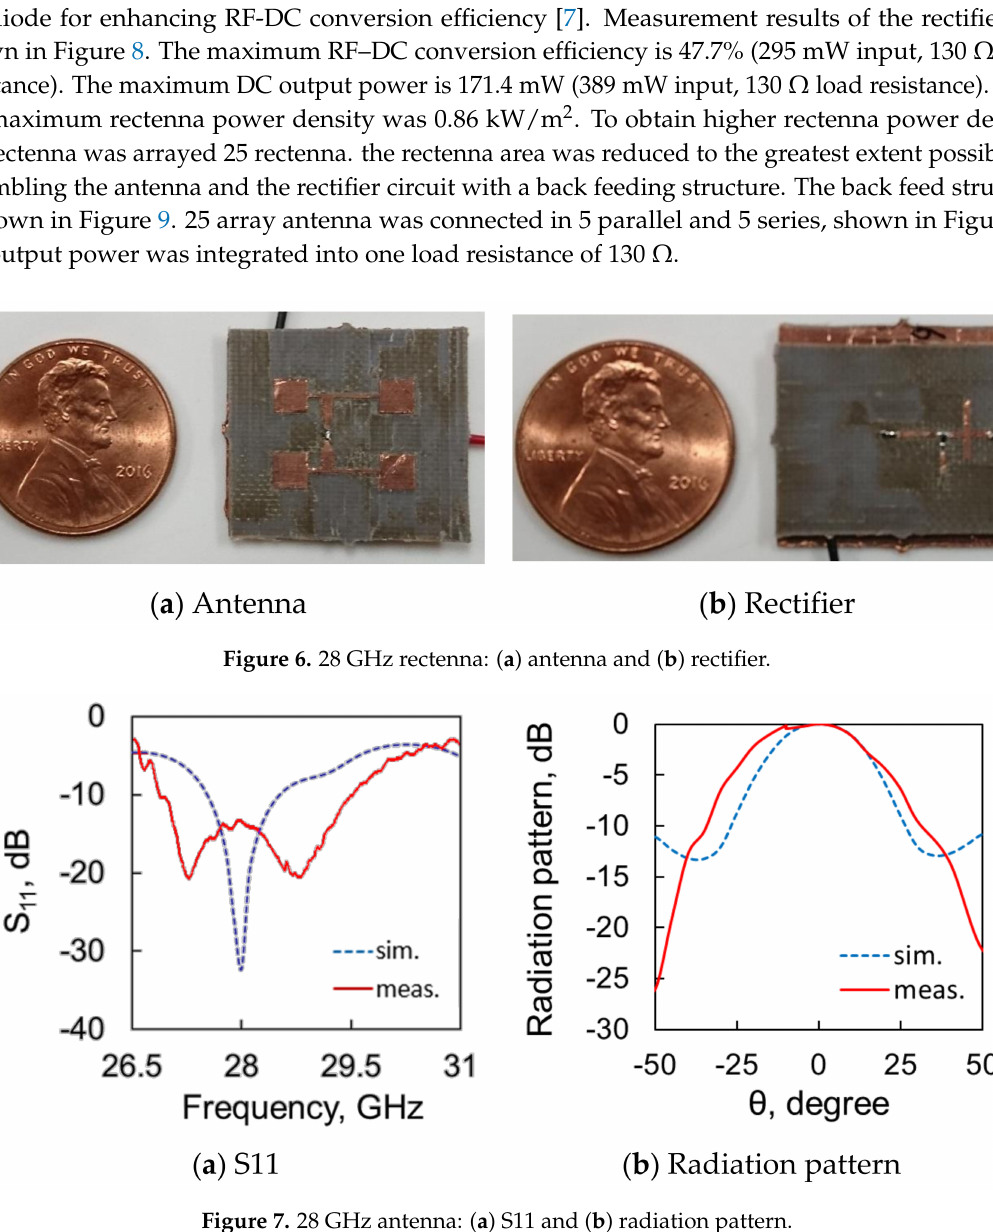
Figure 7. 28 GHz antenna: ( a ) S11 and ( b ) radiation